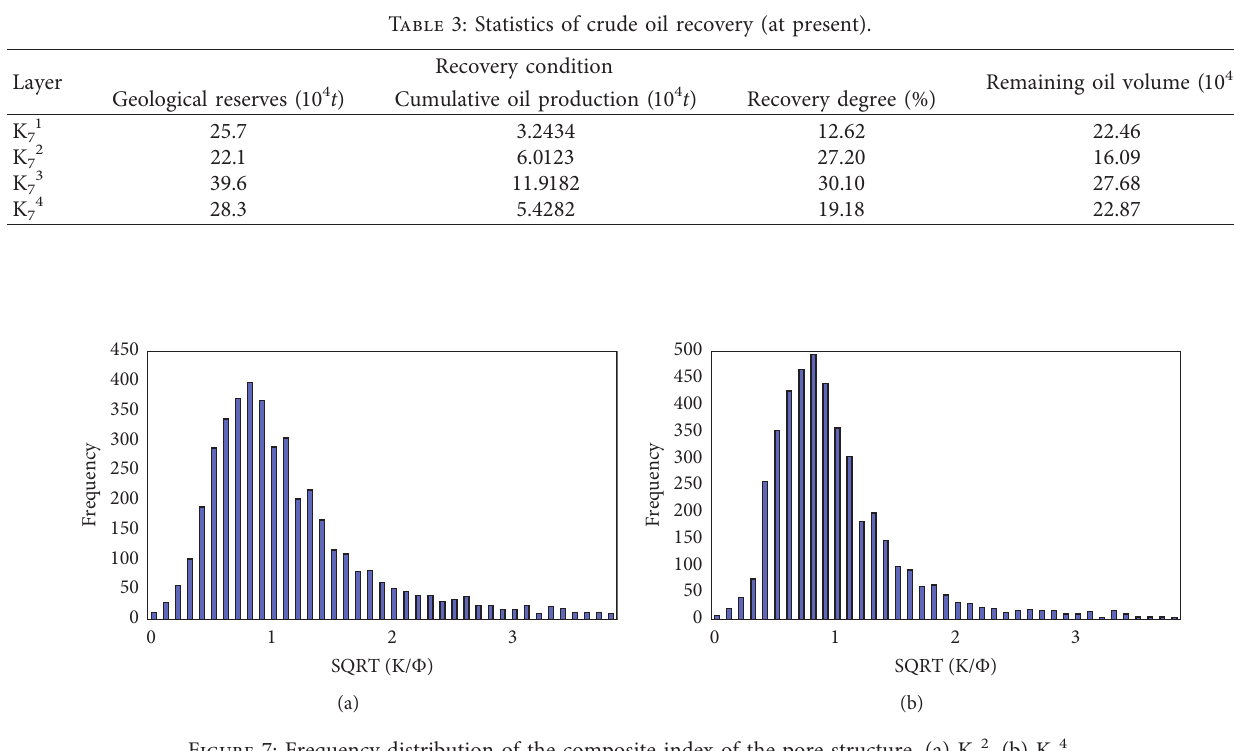
Figure 7: Frequency distribution of the composite index of the pore structure. (a) K 72 . (b) K 74